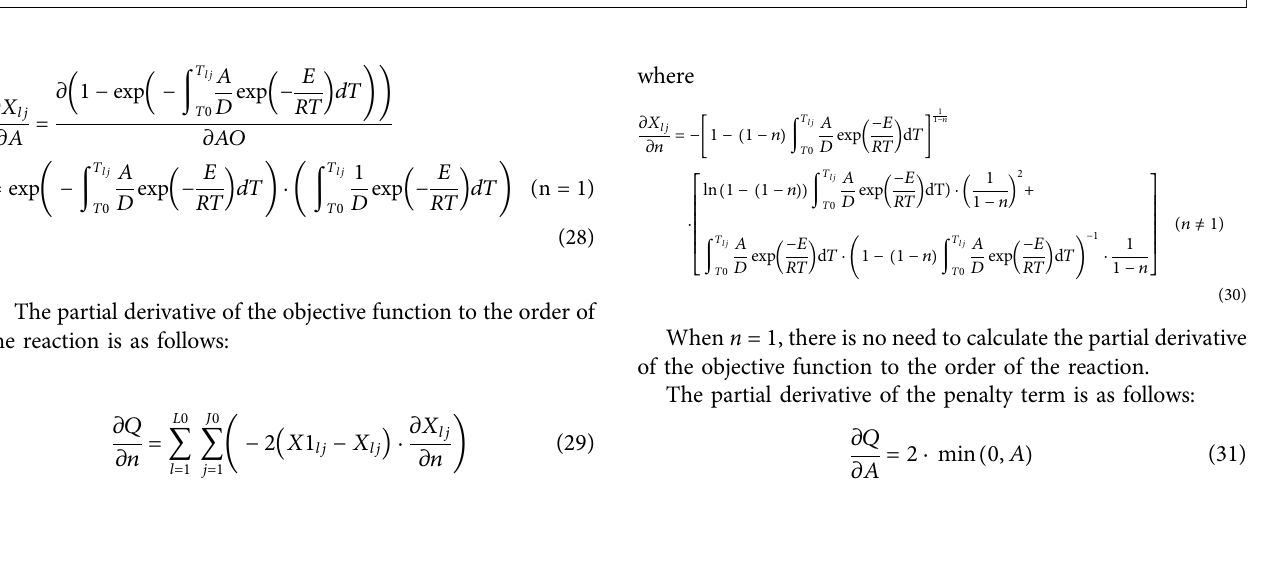
FIGURE 6 | Comparison of the fi tting effects of the parallel fi rst – order reaction model and the overall nth – order reaction model on experimental data of sample No. Nine in the open system experiments. Figures 6A, C, E are the fi tting effect of the parallel fi rst – order reaction on the generation of C 1 – 5 , C 6 – 14 and C 14+ , respectively; Figures 6B, D, F are the fi tting effect of the overall nth – order reaction on the generation of C 1 – 5 , C 6 – 14 and C 14+ , respectively.